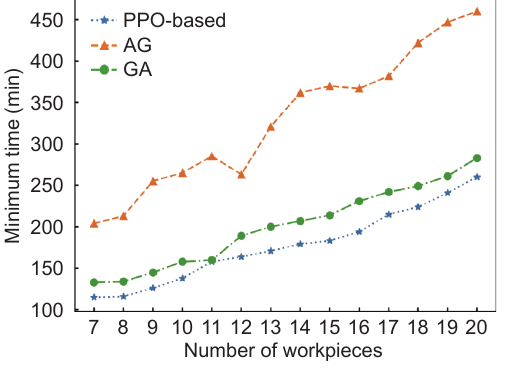
Fig. 2 Distribution 1 scheduling result.